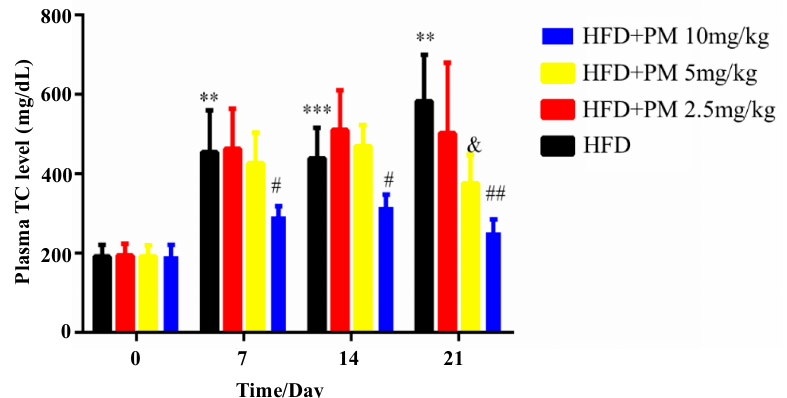
Figure 8. Dose-dependent cholesterol-lowering effects of the SIM-EZE PM. LDLr − / − mice have been administrated in three different doses (2.5, 5, and 10 mg/kg/day) of SIM-EZE PM by gavage while fed with a high-fat diet for 21 days. ** p < 0.01, *** p < 0.001, compared with the HFD model group on day 0; & p < 0.01, 5 mg/kg SIM-EZE PM compared with the HFD model group on day 21; # p < 0.05, ## p < 0.01, 10 mg/kg/day SIM-EZE PM compared with the HFD model group on the equal day.